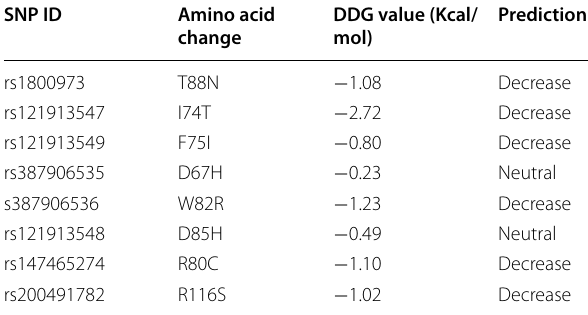
Table 2 Prediction by I-Mutant 3.0